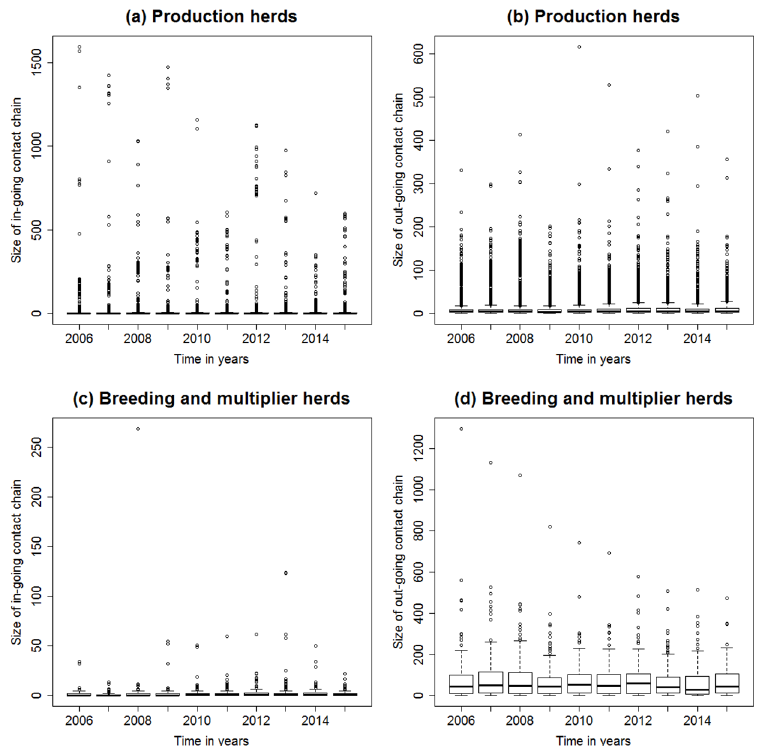
Fig 7. Contact chains for production and breeding and multiplier herds. Boxplots of (a) in-goingand (b) out-goingcontact chains for production herds and (c) in-goingand (d) out-goingcontact chains for breeding and multiplier herds from 2006 to